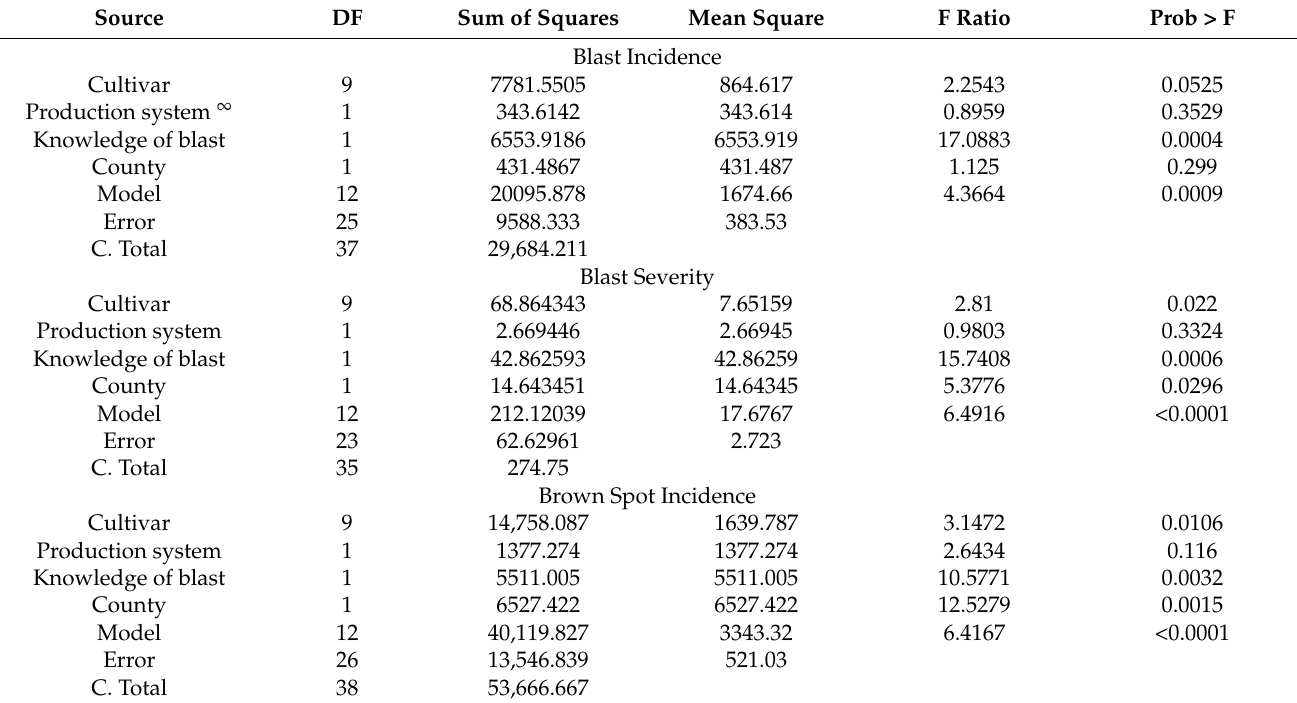
Table 3. Factors associated with the occurrence of rice blast and brown spot diseases in Busia and Kisumu Counties of Kenya during the crop seasons of 2019.